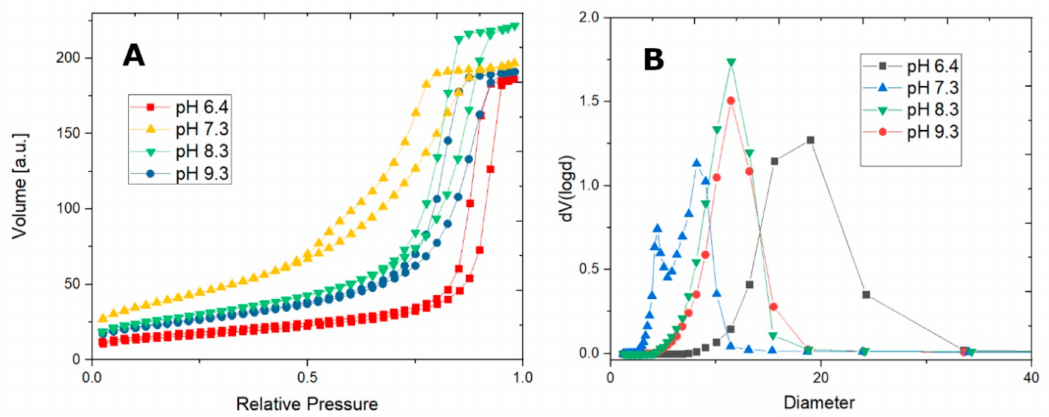
Figure 2. N 2 sorption isotherms ( A ) and pore size distribution plot ( B ) for the cobalt ferrites synthesized pH values between 6.4 and